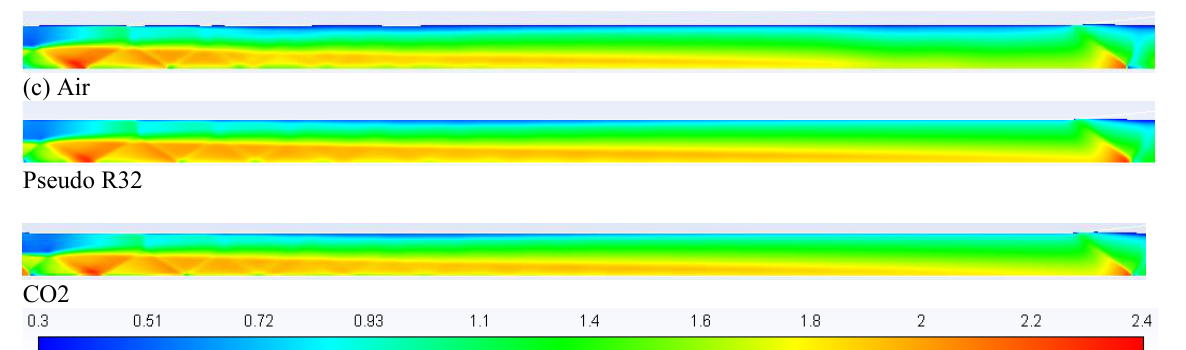
Fig. 5 . Mach contours of different ideal gases